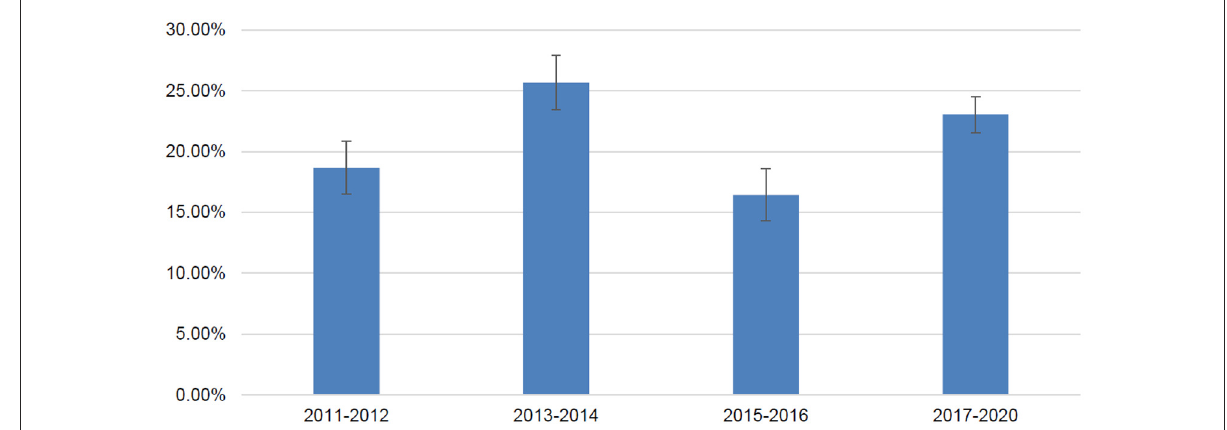
FIGURE1 Prevalence of antidepressant use in adult cancer survivors in United States by NHANES data